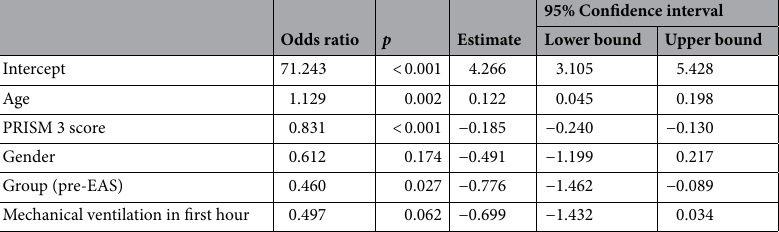
Table 3. Multivariate logistic regression analysis for mortality as the dependent outcome. PRISM 3 Pediatric Risk of Mortality III; EAS electronic alert system. Outcome level “Survived” was coded as class 1. Model performance metrics: area under curve = 0.857, sensitivity = 0.940, specificity = 0.500, precision = 0.860.